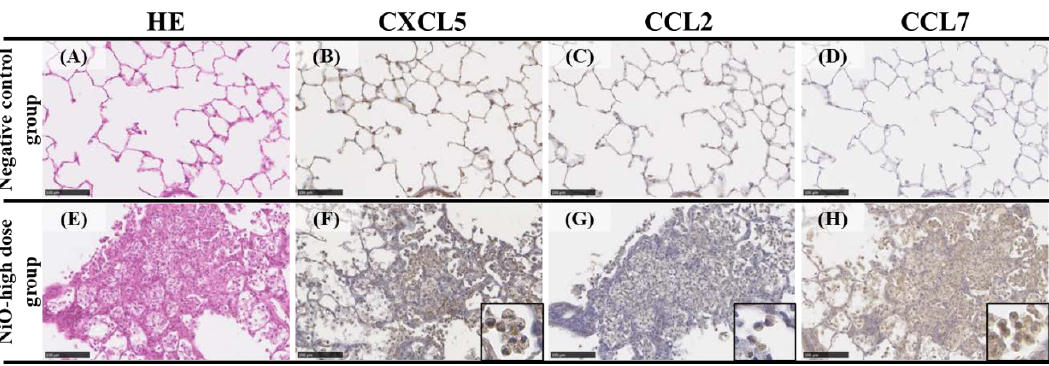
Figure 2. Representative images of CXCL5, CCL2, and CCL7 immunostaining in lung tissue exposed